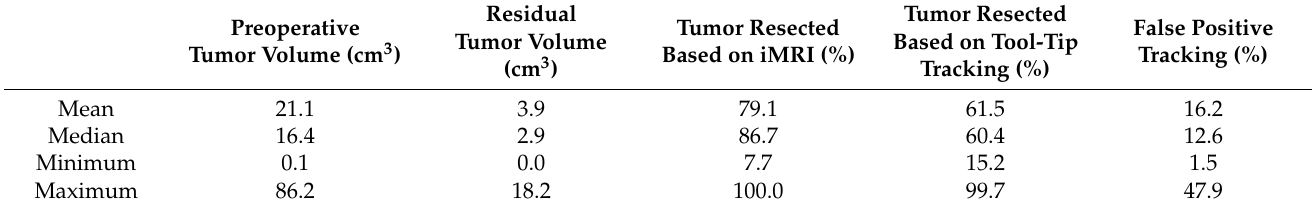
Table 3. Summary of measurements of the volume of the tumor segmented from preoperative MRI, the volume of the residual tumor segmented from iMRI, the % of the preoperative tumor resected at the time of iMRI, the % of the preoperative tumor covered by the tracked resection cavity (True Positive Tracking), and the % of the residual tumor covered by the tracked resection cavity (False Positive Tracking). For the complete set of measurements, see Appendix A, Table